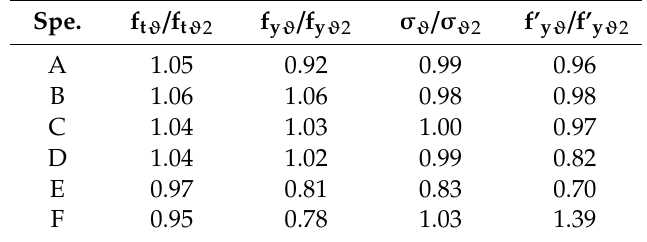
Figure 17. Ultimate load enhancement ratio of the CFRP bonding segment structure and joint. Table 10. Comparison between the analytical and experimental